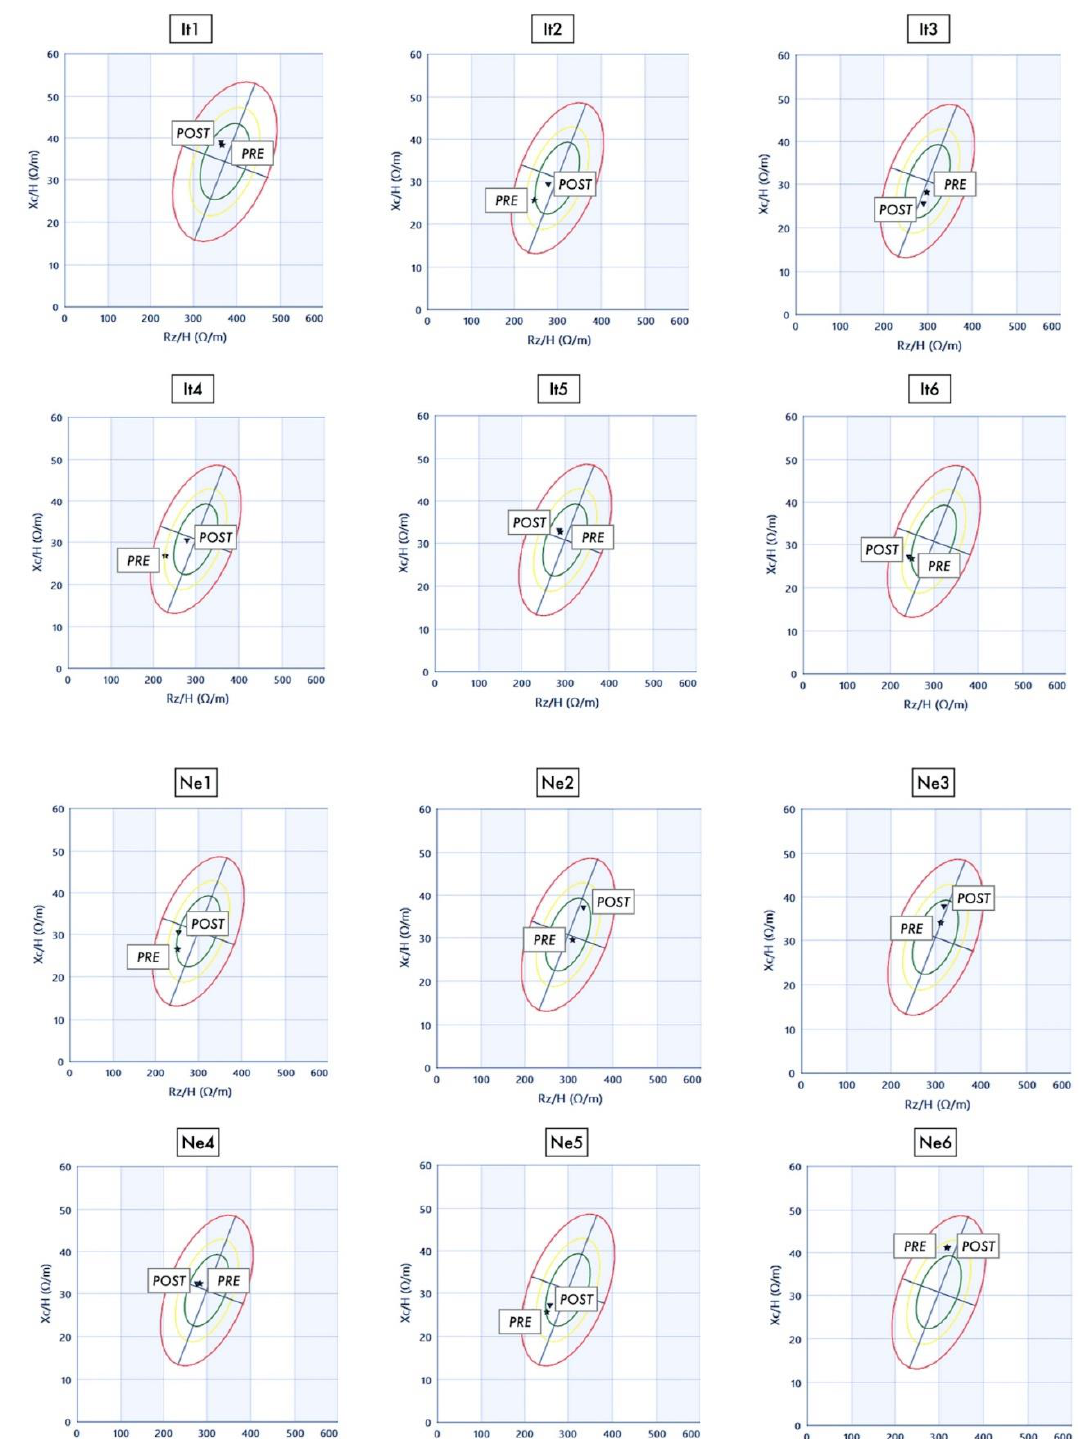
Figure 3. Bioimpedance vector analysis (BIVA) graphs of both Italian (It1–6) and Nepalese (Ne1–6) participants. Raw bioimpedance parameters (i.e., resistance, Rz, and reactance, Xc) are standardised for height and plotted as a vector, of which the direction and length are determined by the hydration status and dielectric mass of soft tissues. The graphs are built according to the up-to-date tolerance ellipses of a reference population (50%, 75% and 95%, from the innermost to the outermost). Stars (PRE) and triangles (POST) represent the first and the last measurement, conducted the day before and the day after the altitude expedition, respectively.